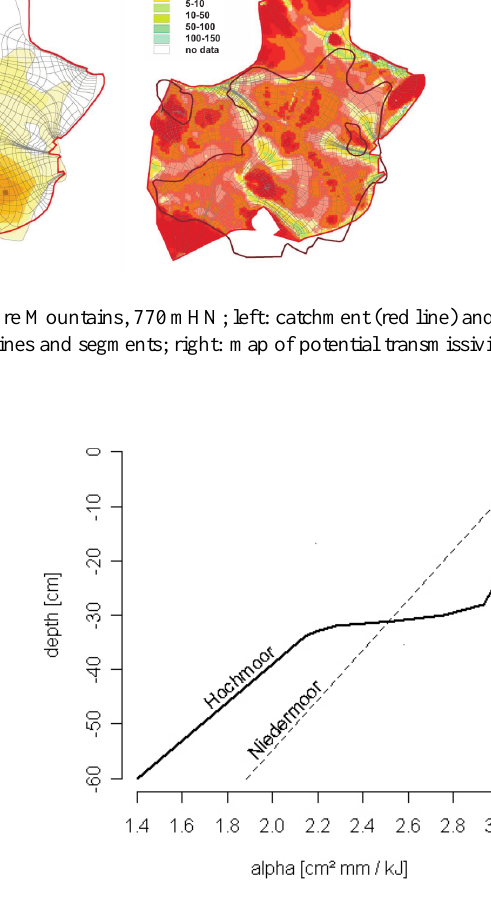
Fig. 2. Specific evapotranspiration α for bog=Hochmoor ( Spag- num -lawn with low shrubs) and fen=Niedermoor (brownmoss- small sedge-fen) by different groundwater tables in June, July, and August (combined by Romanov, 1961, 1962; Kaljuˇznyj et al., 1988; modified by Edom,